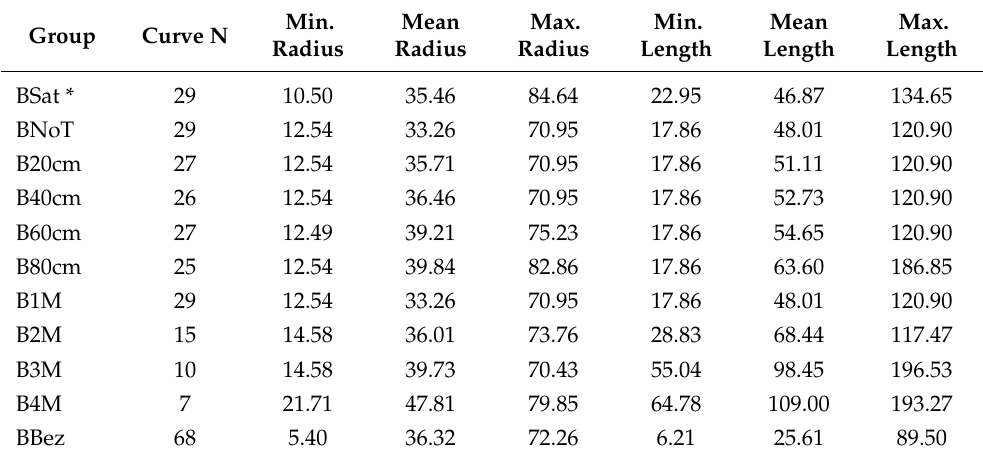
* BSat stands for: B = forest road and Sat = control data obtained from the satellite